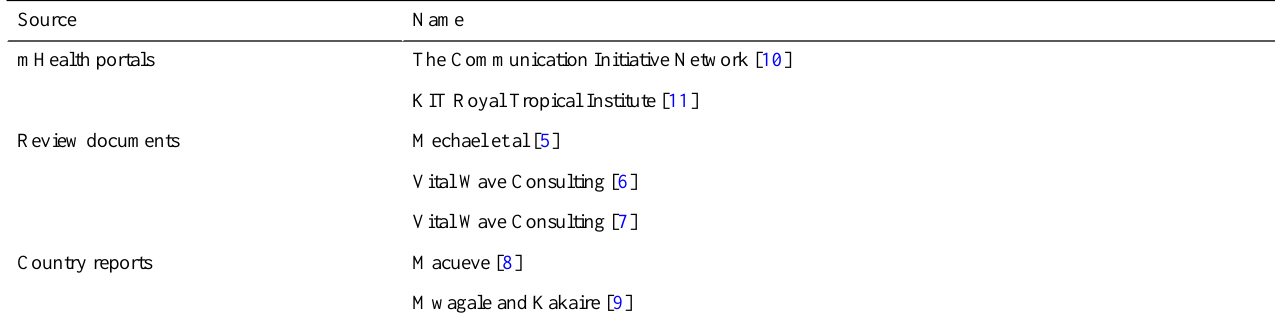
Table 1. Sources used to identify mHealth